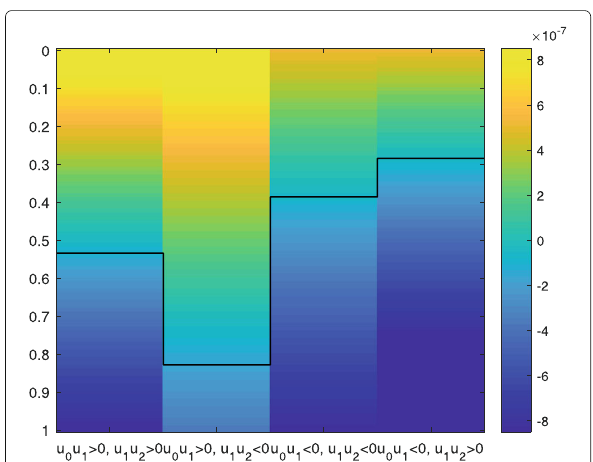
Fig. 4 Heatmap: Threshold on γ 2 to ensure honored commitments in period T . The graph shows the threshold on γ 2 (y-axis) for each potential sequence of shock realizations (x-axis) in black, conditional on p r = 0.10. Yellowish (blueish) colors indicate values of γ 2 , conditional on a potential shock sequence, for which a policy deviation is favorable (not favorable) in terms of welfare. If γ 2 > ¯ γ